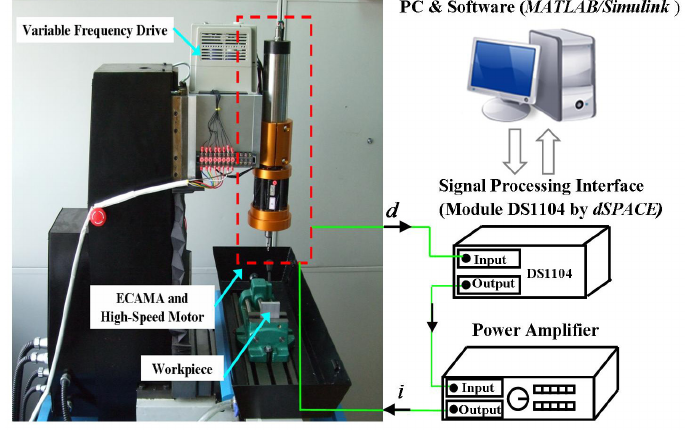
Figure 15. Test rig for milling operation.